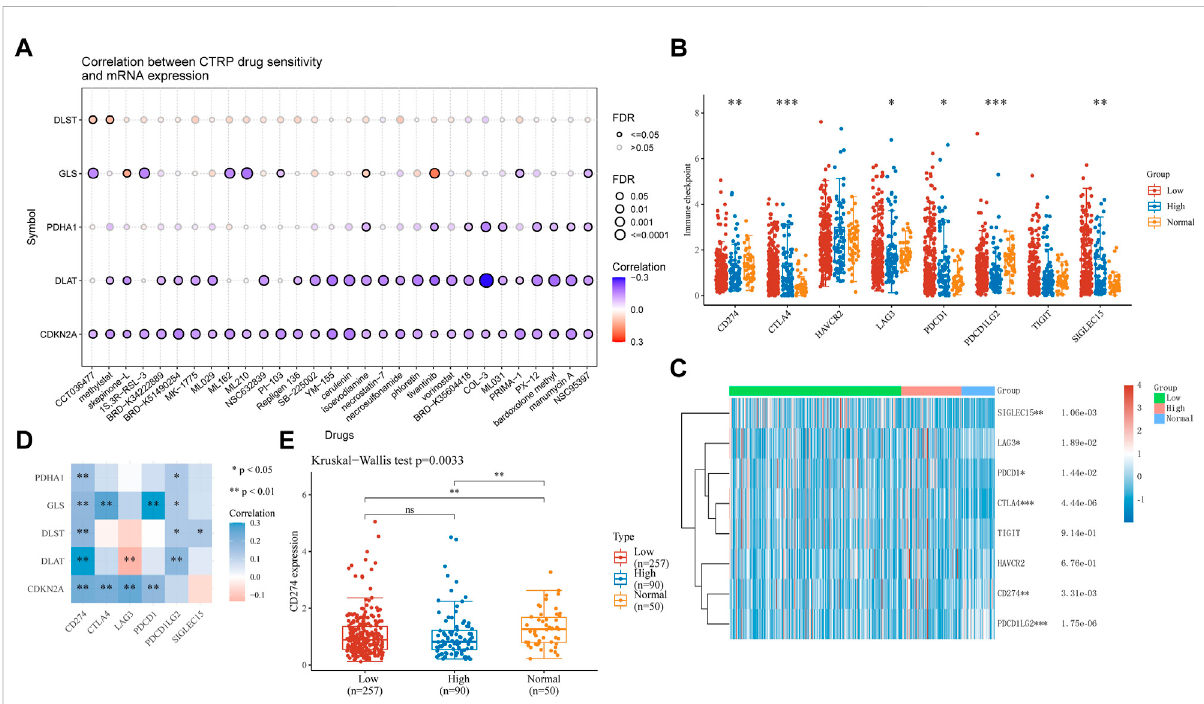
FIGURE 10 Drug sensitivity and immune checkpoints analysis (A) Drug-sensitivity analysis of fi ve prognostic CRGs in HCC. (B) , (C) Different expressions of immune-checkpoints in low-, high-grade and adjacent normal tissue in HCC. (* p < 0.05, ** p < 0.01, *** p < 0.001, asterisks (*) stand for signi fi cance levels.) (D) The correlation analysis between fi ve prognostic CRGs and immune checkpoints. (E) The expression of CD274 in low-, high-grade and adjacent normal tissue in HCC. (* p < 0.05, ** p < 0.01, *** p < 0.001, asterisks (*) stand for signi fi cance